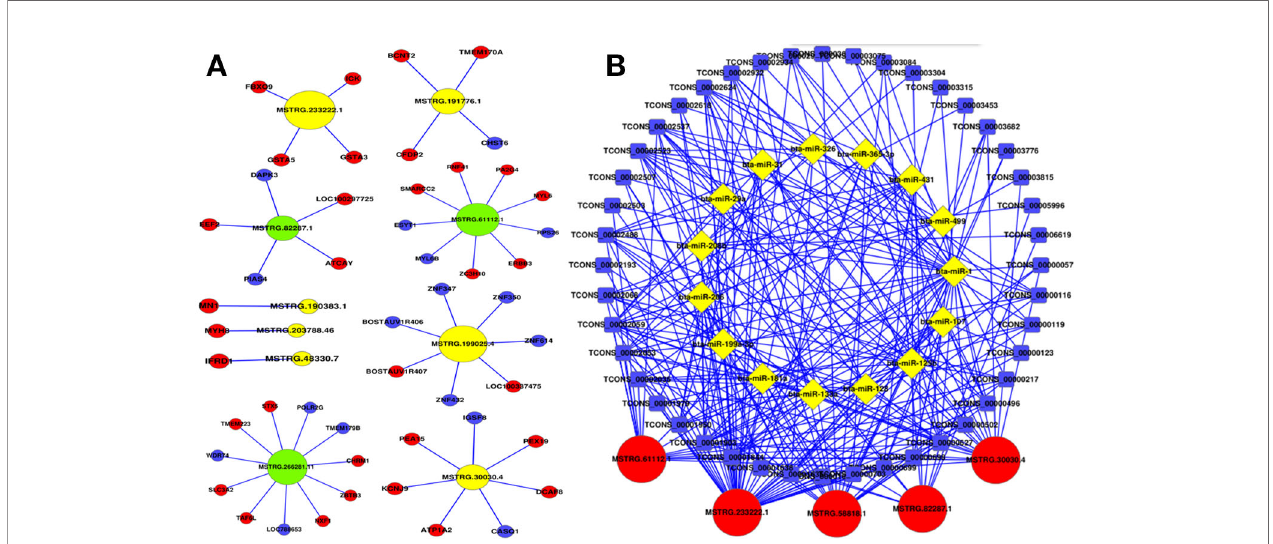
FIGURE 5 | Coexpression network and competing endogenous RNA network in cattle and buffalo muscle tissues. (A) LncRNAs and their potential cis regulated nearby genes are shown in the network. (B) The network includes lncRNA-miRNA and miRNA-mRNA interactions, whereby edges indicate sequence matching, and lncRNAs connect ties suggesting miRNA-mediated mRNA expression.